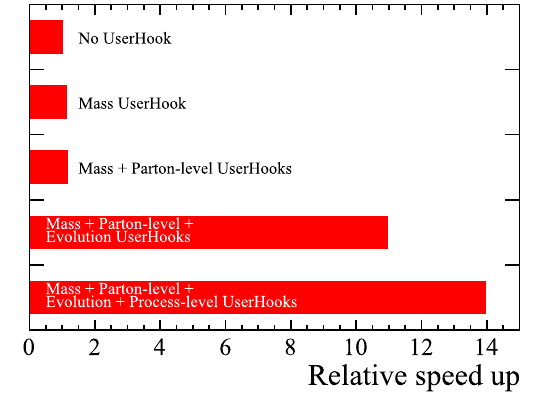
Fig. 8 Relative speed enhancements of Pythia when generating B + c mesons with the different UserHooks included. Each point includes an additional UserHook as described in the